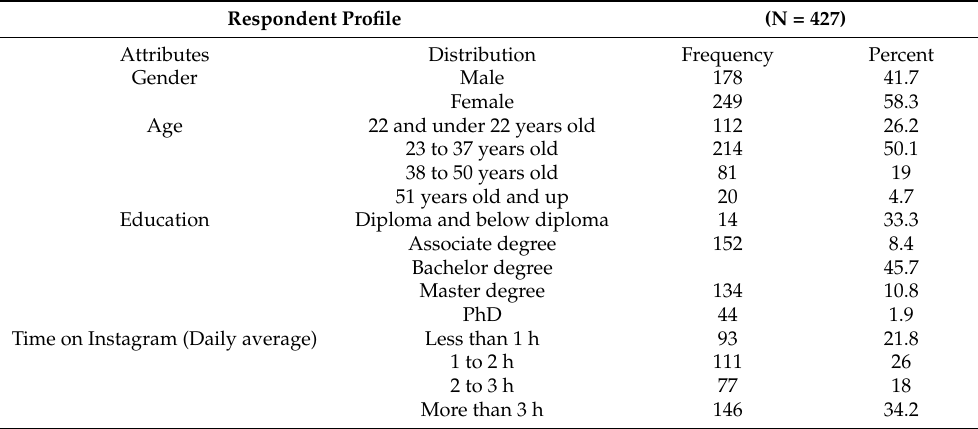
Table 1. Demographic